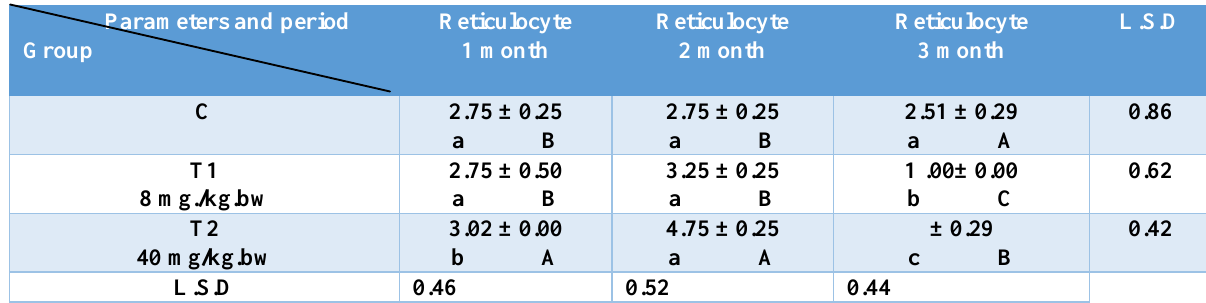
Table, 8: Values of Reticulocytes (%) in blood of rats treated with different doses of CuSO4.5H2O